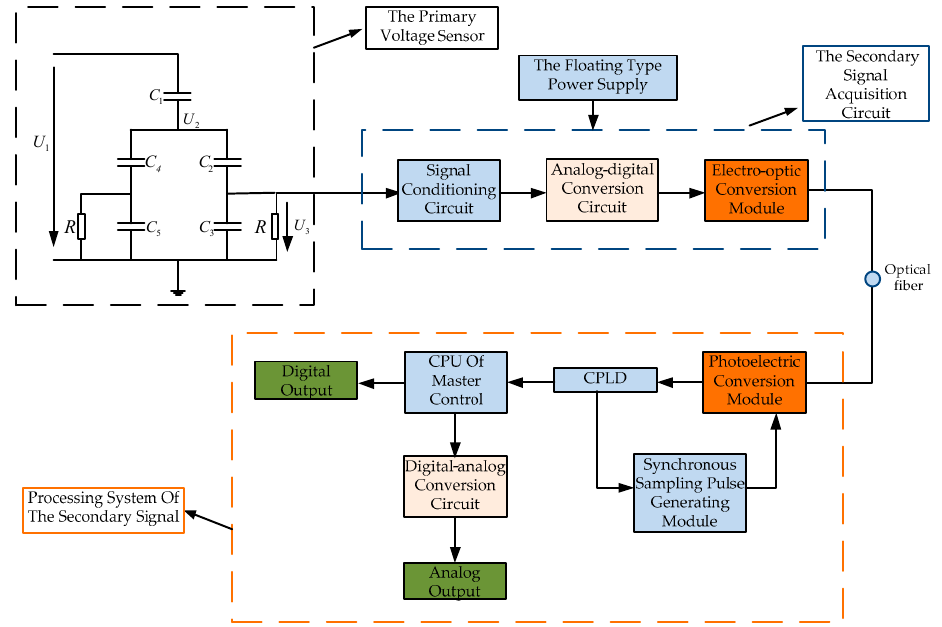
Figure 1. Structural schematic diagram of Electronic Capacitive Voltage Transformer (ECVT).